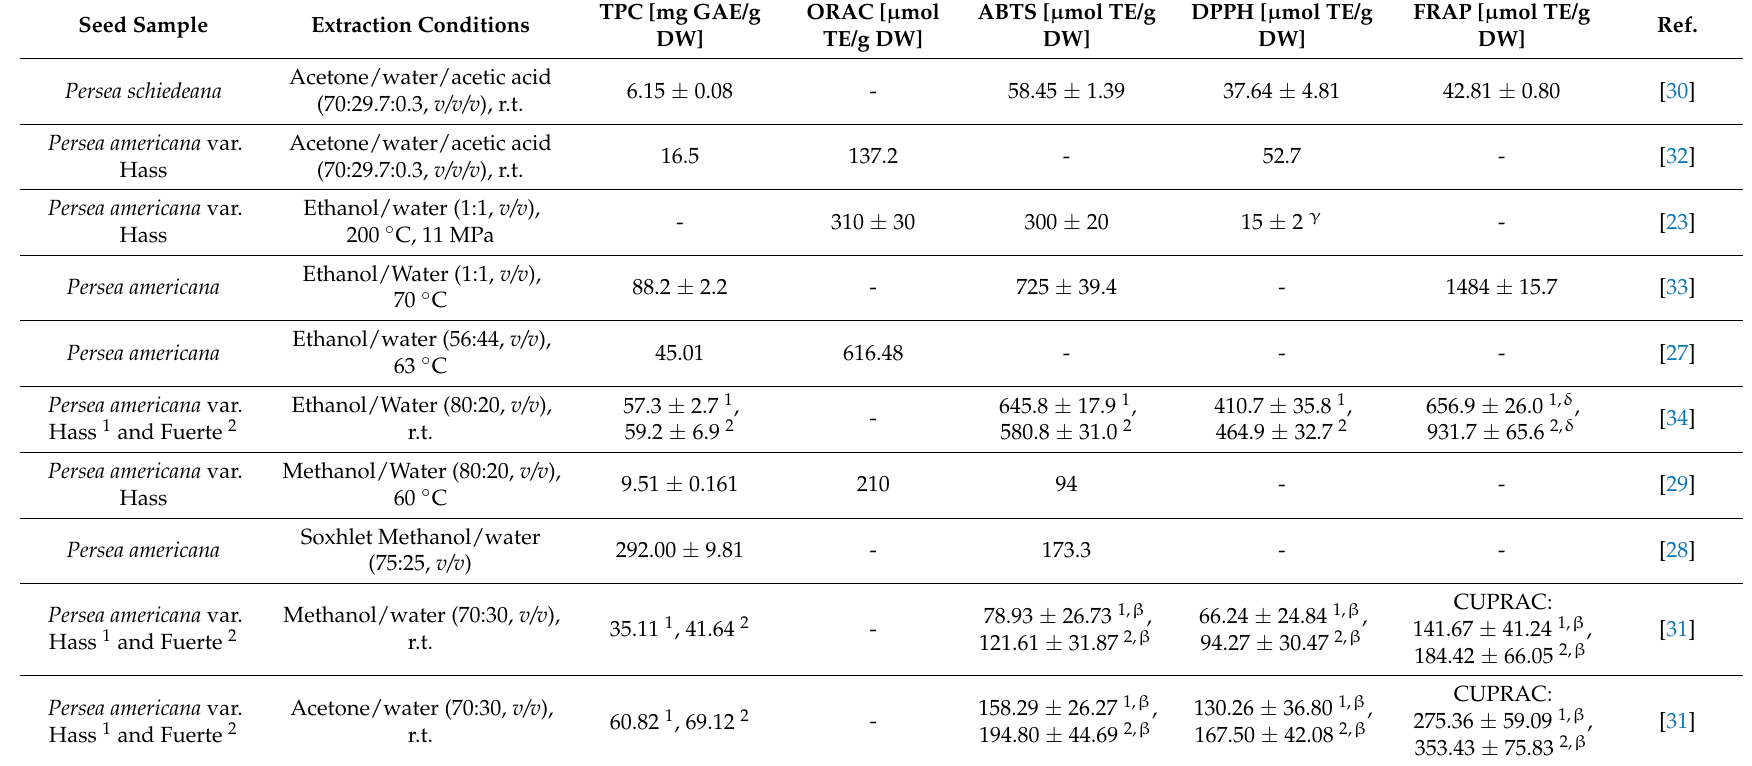
Table 1. Different radical scavenging values found in the